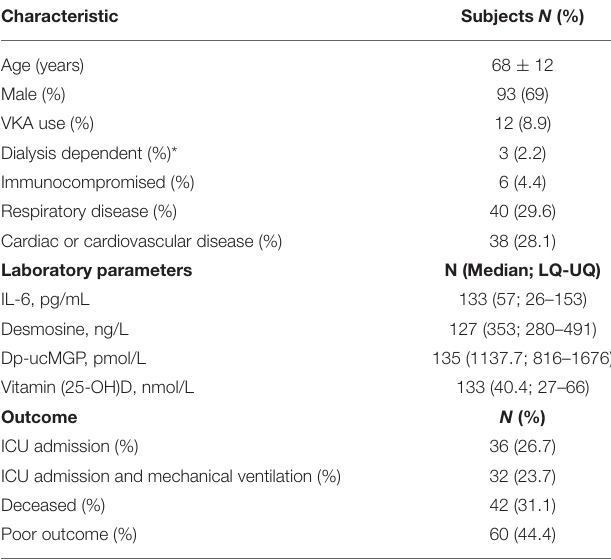
TABLE 1 | Baseline characteristics and outcome of all 135 individuals.